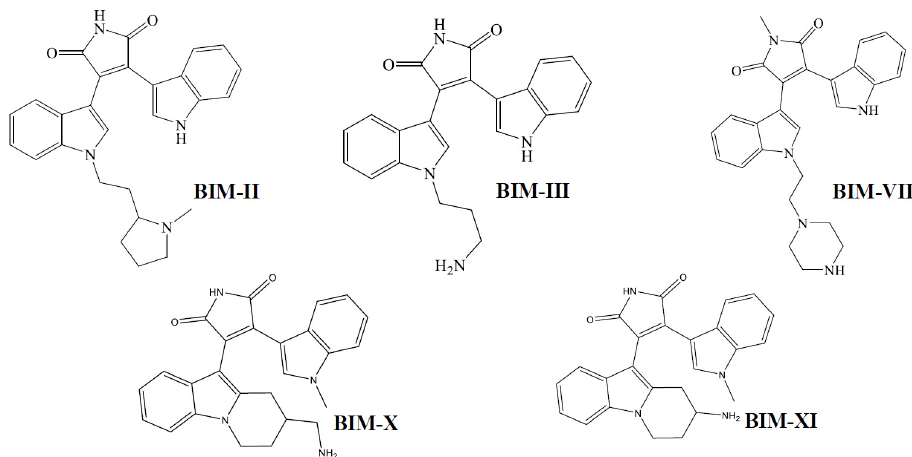
Figure 1. Chemical Structures of BIMs.